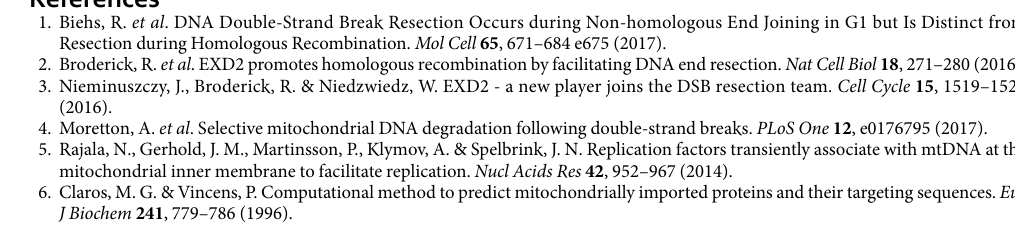
anti-rabbit IgG conjugated to Alexa Fluor 555 (1:1000 in PBS) and anti-mouse IgG conjugated to Alexa Fluor 488 (1:1000 in PBS, Molecular Probes A21151). Cells were washed 3x with PBST and DNA was counterstained with DAPI. A final wash was performed with PBS. Coverslips were mounted using 10ul PBS/Glycerol (50/50, v/v) and observed using a Leica MMAF Imaging NX microscope powered by Metamorph. Data availability. The data generated during and/or analyzed during the current study are available from the corresponding author on reasonable request.